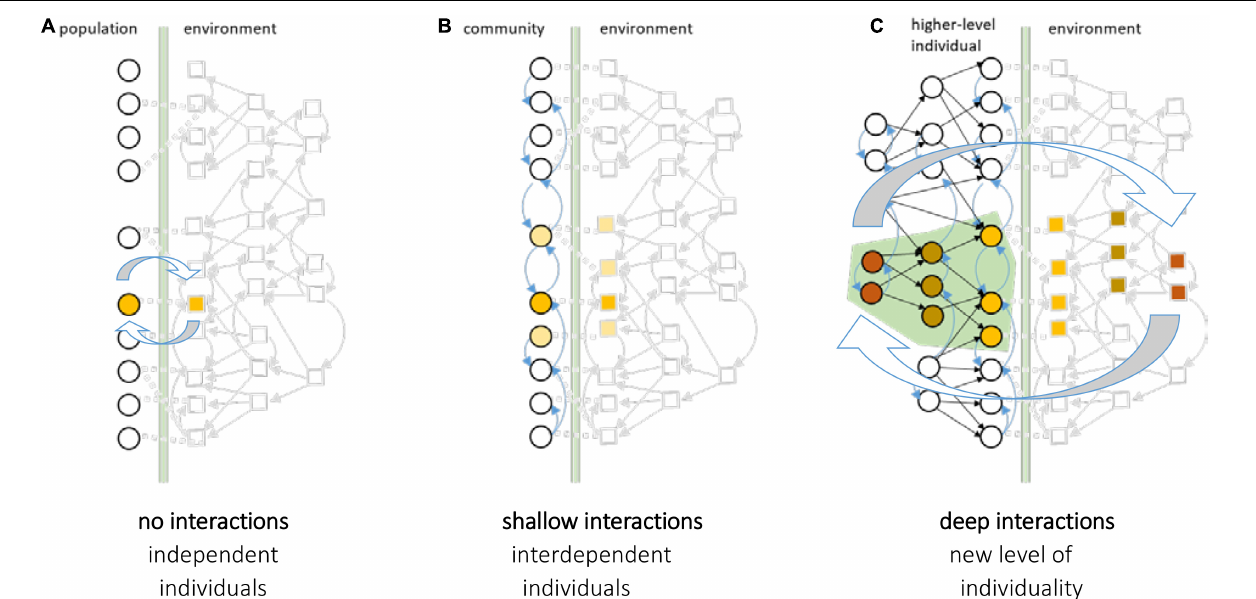
FIGURE 2 | Overview of conventional models of evolution (A), previous work in evolutionary connectionism (B) and Hypothesis 1 (C). (A) A conventional view of evolution models individual evolutionary units in a population. The complexity of the environment is not “visible” to evolution – selection on an individual (orange circle) responds only to corresponding additive effects of selection in the environment (orange square) (large arrows). At the population level, this is formally equivalent to simple (model-free) forms of learning and inference (Frank, 2009; Harper, 2009; Shalizi, 2009). (B) When individual traits affect behavioural or phenotypic interactions with other individuals, these relationships can evolve to “mirror” dependencies among environmental variables. When interactions are reciprocal (single-level) the evolution of the community is formally equivalent to shallow models of connectionist learning (Watson et al., 2014, 2016; Power et al., 2015; Kouvaris et al., 2017). (C) We hypothesise that when functional interactions between individuals in a community are directional, creating deep interaction structures with “hidden” variables, evolution is formally equivalent to deep model induction. When evolved functions are non-linearly separable, and their outputs control the coordination of particle reproduction, the hierarchical structures so created constitute new individuals at a higher level of organisation (e.g., green). The functional interactions between component individuals constitute a developmental process for this higher-level individual, and enable information integration and collective actions at a new level of biological organisation. Adaptations under natural selection (acting on deep variables, red circles) now serve the development, survival and reproduction of the new individual (large arrows), and deep causal variables in development (red circles) mirror deep causal variables in the selective environment (red